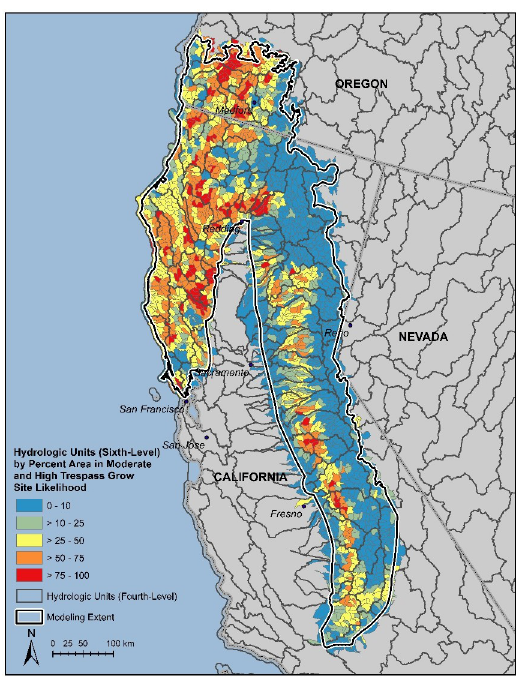
Fig 3. Proportion of modeled moderate-high cannabis cultivation likelihood summarized within HUC12 subwatersheds in the modeling extent.